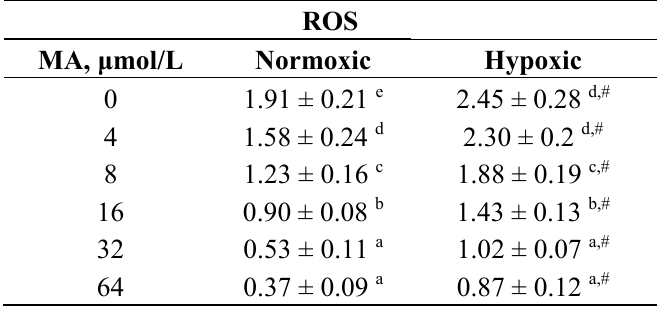
Table 1. Effects of MA at 0, 4, 8, 16, 32 or 64 μ mol/L upon level of ROS (nmol/mg protein) and NO ( μ M/mg protein) in A549 cells under normoxic and hypoxic conditions. Data are mean ± SD ( n =